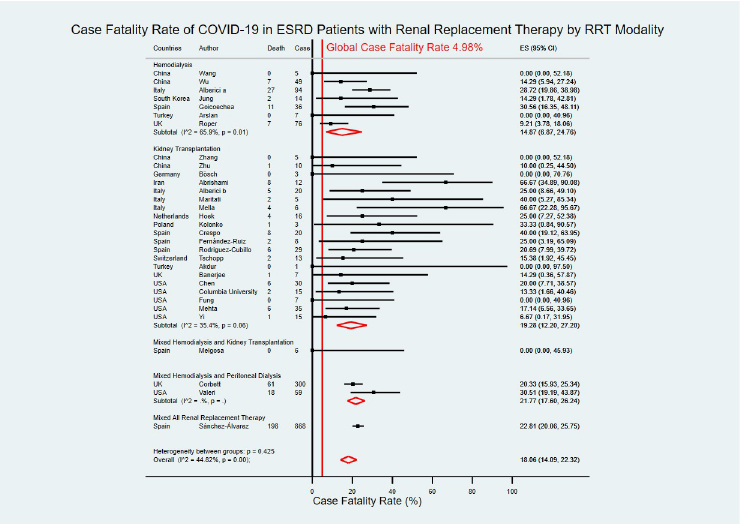
Fig 9. Forest plot of the case fatality rate of COVID-19 in ESRD patients with RRT by RRT modality. The figure summarizes the number of COVID-19 deaths in ESRD patients with RRT and the number of COVID-19 confirmed cases in ESRD patients with RRT in 31 eligible studies with subgroup analysis by types of RRT modality. The forest plot represents the estimated case fatality rate of COVID-19 in ESRD patients with RRT for each study (black boxes), with 95% confidence intervals (95% CI; horizontal black lines). The estimated pooled case fatality rate for each subgroup was presented with a red diamond. The overall estimated pooled case fatality rate (last red diamond) was 18.06% (95% CI 14.09–22.32). The global case fatality rate (vertical red line) was 4.98%. The meta-analysis used a random-effects model with the exact method for confidence interval estimation. ES, effect size. I 2 , test for